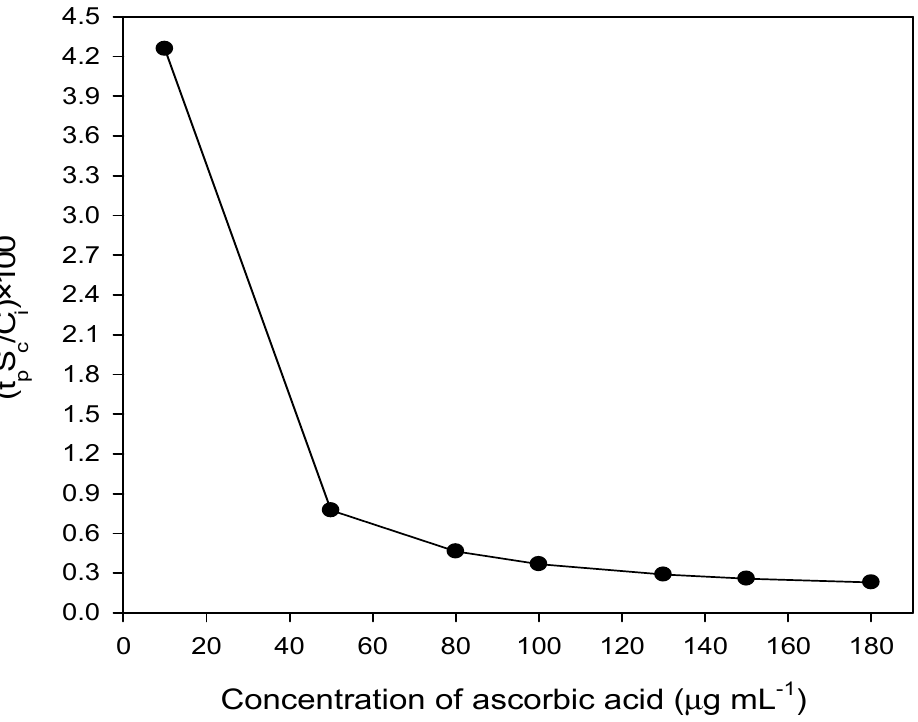
Figure 6. % Uncertainty confidence limit in the determination of ascorbic acid at 95% confidence level.